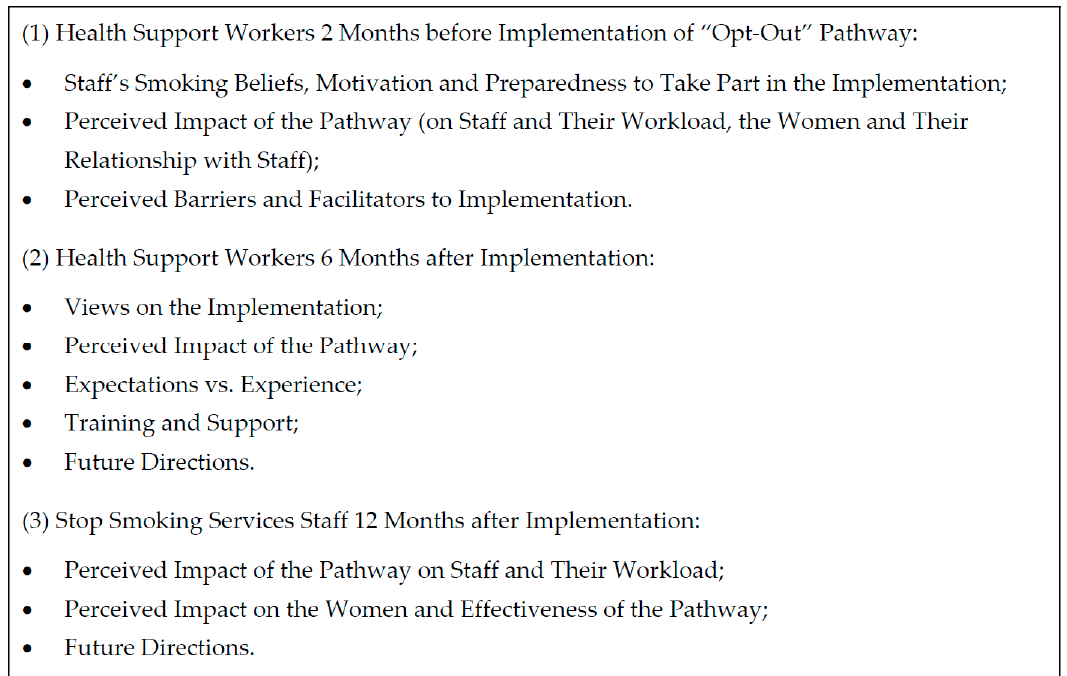
Figure 1. Interview timeline.